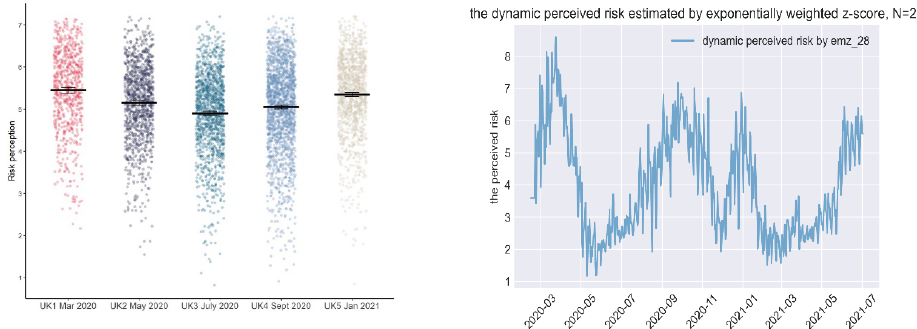
Figure A3. The risk perception comparison between survey results and emz_28.